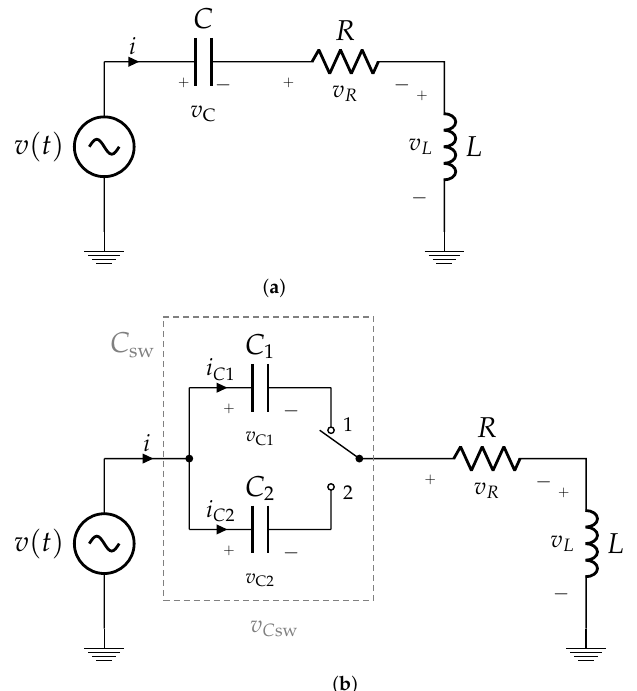
Figure 5. A harmonic voltage source with a capacitor and RL load in series: ( a ) single capacitor; and ( b ) switched capacitor equivalent.